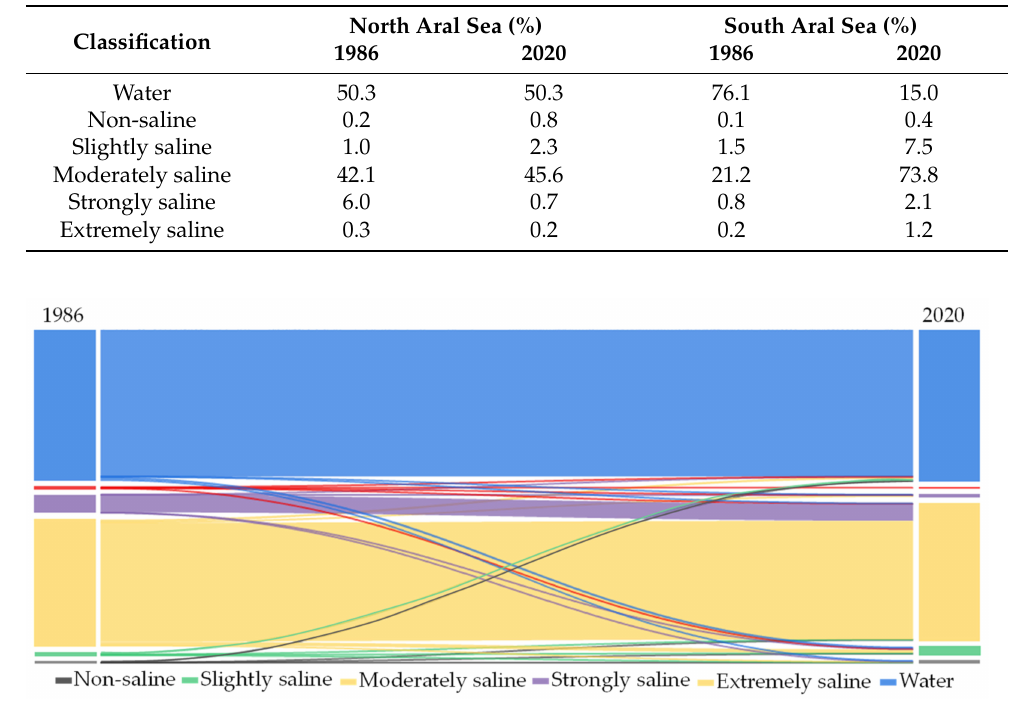
flows “begin” (1986) and “end” (2020) at each node, and the transition lines between the paired salinity class categories are applied to show these flows. In addition, the stacked bar indicates the proportion of each soil salinity class, and the width of the direction line is directly proportional to the magnitude of the flow changes.